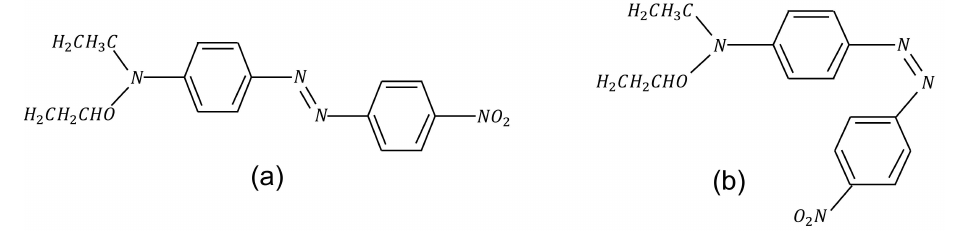
Figure 1. Chemical structures of Disperse Red 1 (DR1) ( a ) trans isomer and ( b ) cis